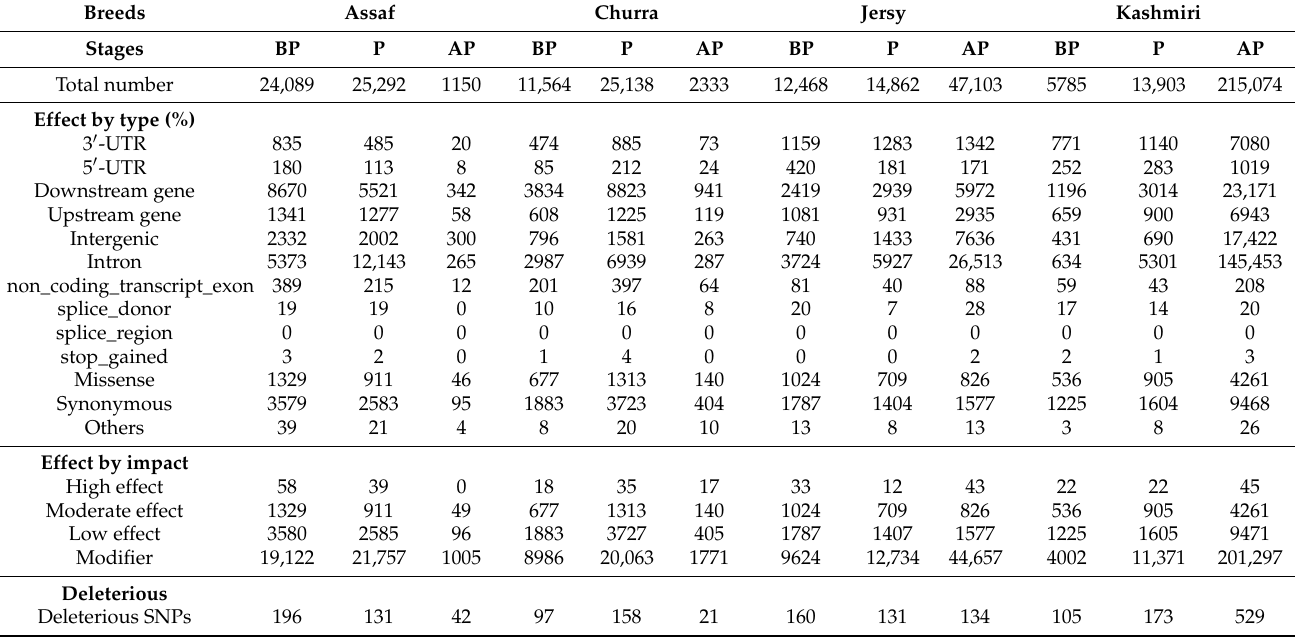
Table 3. Characteristics of the identified breed and stage-specific SNPs in Assaf, Churra, Jersy, and Kashmiri breeds among three different stages of lactation.